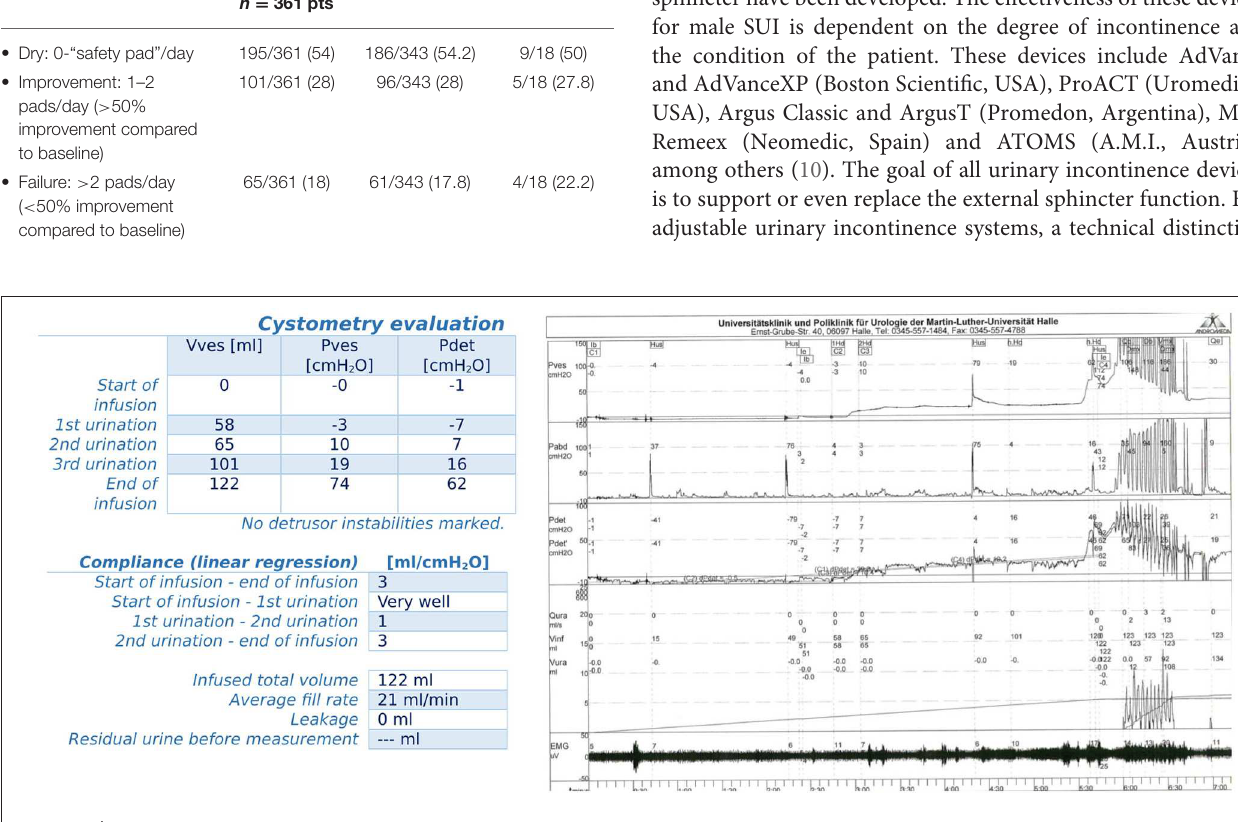
Frontiers in Surgery |